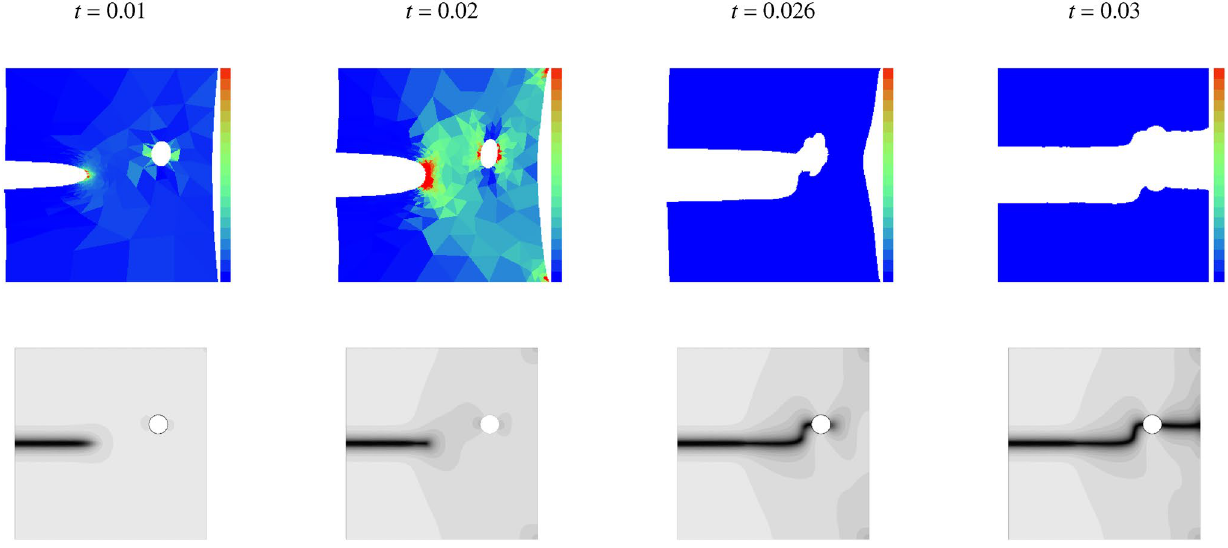
figures, blue color indicates low values, red color high values of the intensity of D